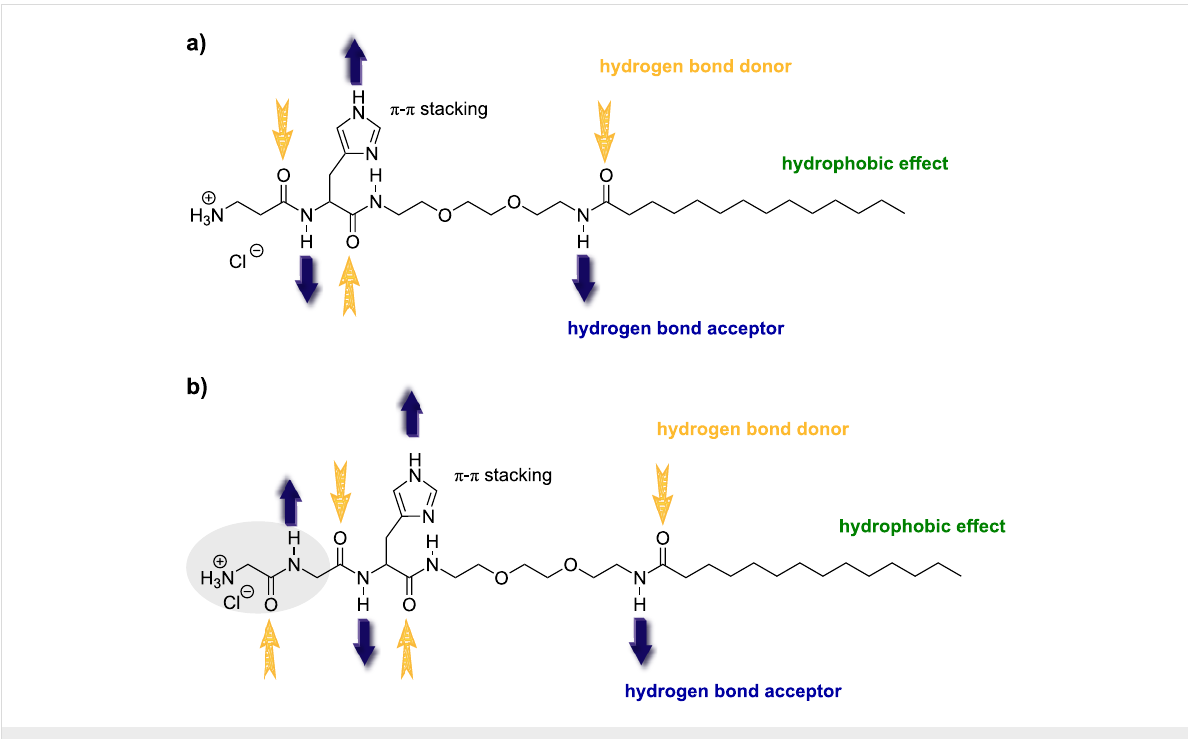
Figure 1: Molecular structures of β -Ala-His-EO 2 -C 14 (a) and Gly-Gly-His-EO 2 -C 14